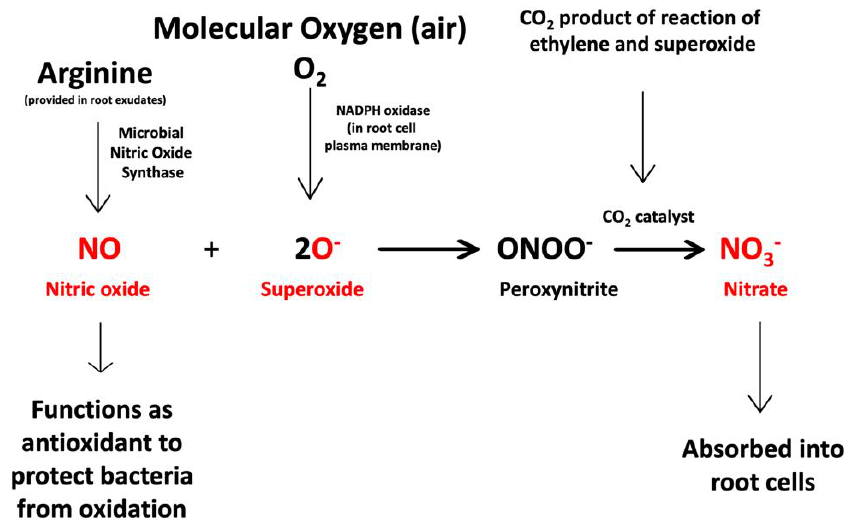
Figure 16. Chemical equation that represents the second interaction between endophytic bacteria and plant cells. Superoxide produced by the plant cell triggers the microbe cells to produce and secrete nitric oxide. The nitric oxide acts as an antioxidant and combines with superoxide to form short-lived peroxynitrite that is catalyzed by carbon dioxide to form nitrate. The nitrate may be absorbed into plant cells by nitrate transporters. Reactants and products detected in histochemical analyses are indicated in red.